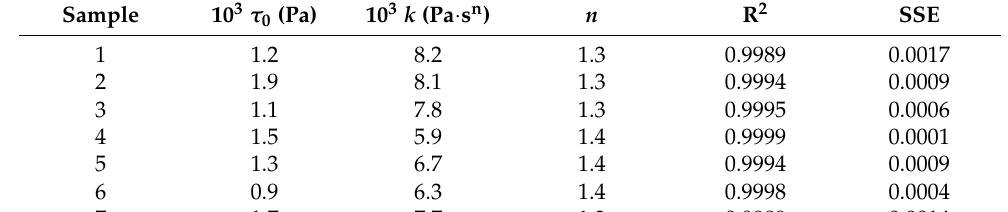
Table 3. Optimized parameters of the Herschel–Bulkley model.